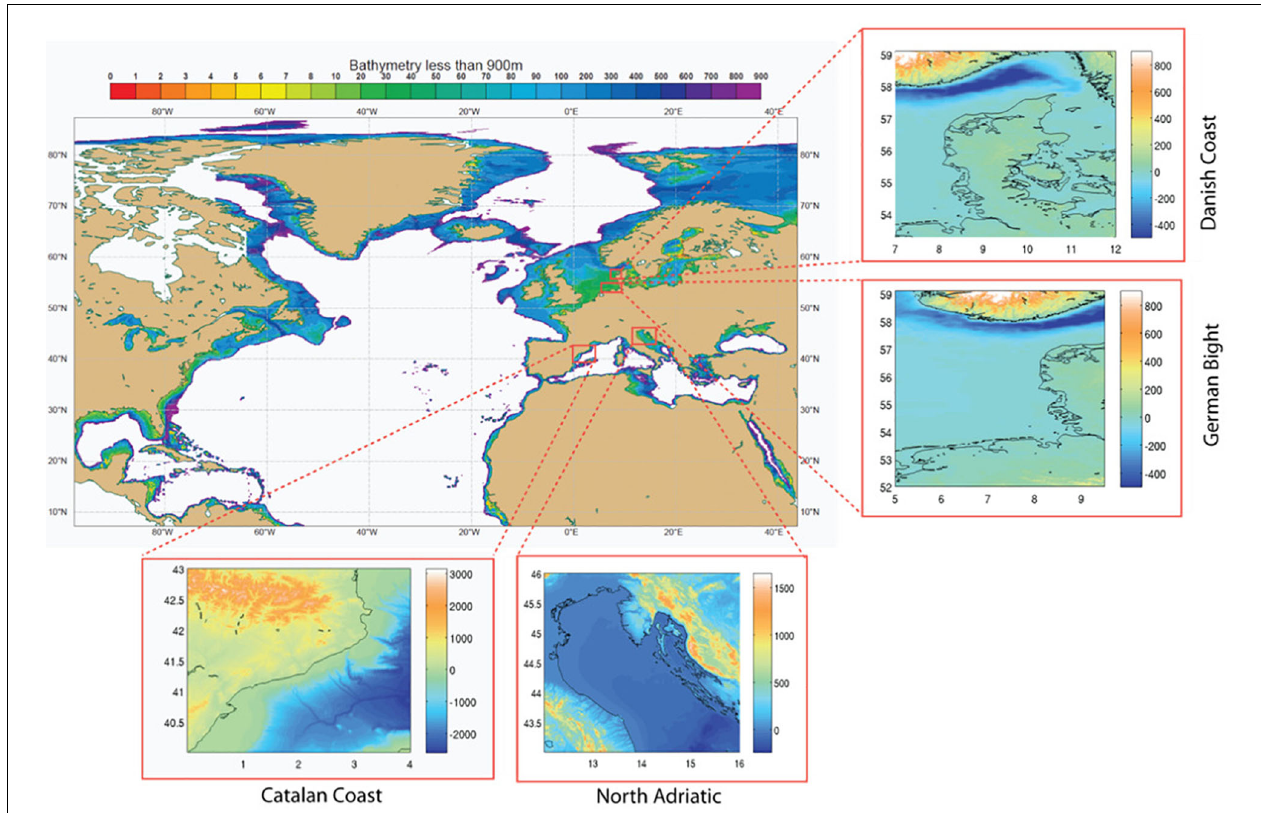
FIGURE 2 | CEASELESS pilot cases: Mediterranean/North Atlantic offshore domains and coastal domains representing open/gulf coasts (Catalan/Northern Adriatic) and estuary/inlet coasts (German Bight/Danish coast).